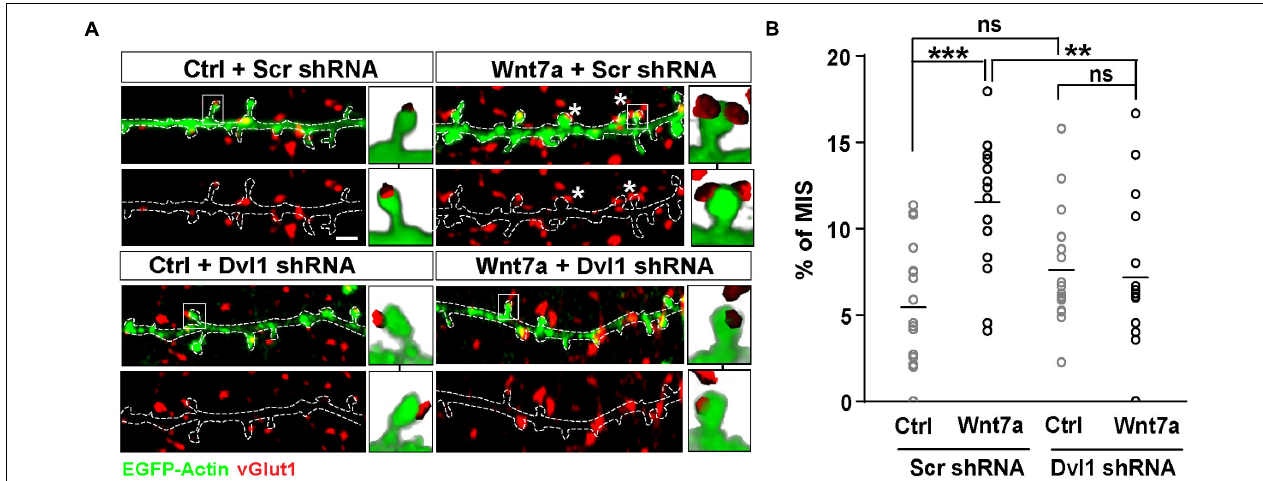
FIGURE 2 | Wnt7a-Dvl1 signaling is required postsynaptically to promote MIS formation. (A) Scrambled (Scr) control or Dvl1 shRNA expressing neurons (13–14 DIV) exposed to control (Ctrl) or Wnt7a conditions for 3 h (scale bar: 1 µ m). Wnt7a-mediated increase in MIS (asterisks) requires Dvl1. Representative images of EGFP-actin dendrites (in green) and vGlut1 (in red) are shown. Three-dimensional zoomed-in images display front (top) and back (bottom) representations of innervated spines with single or multiple vGlut1 puncta. (B) Quantification of mean percentage of MIS in each condition ( n = 16–18 cells/condition from 3 cultures, ** P < 0.01 and *** P < 0.001 by two-way ANOVA followed by Tukey post hoc test).